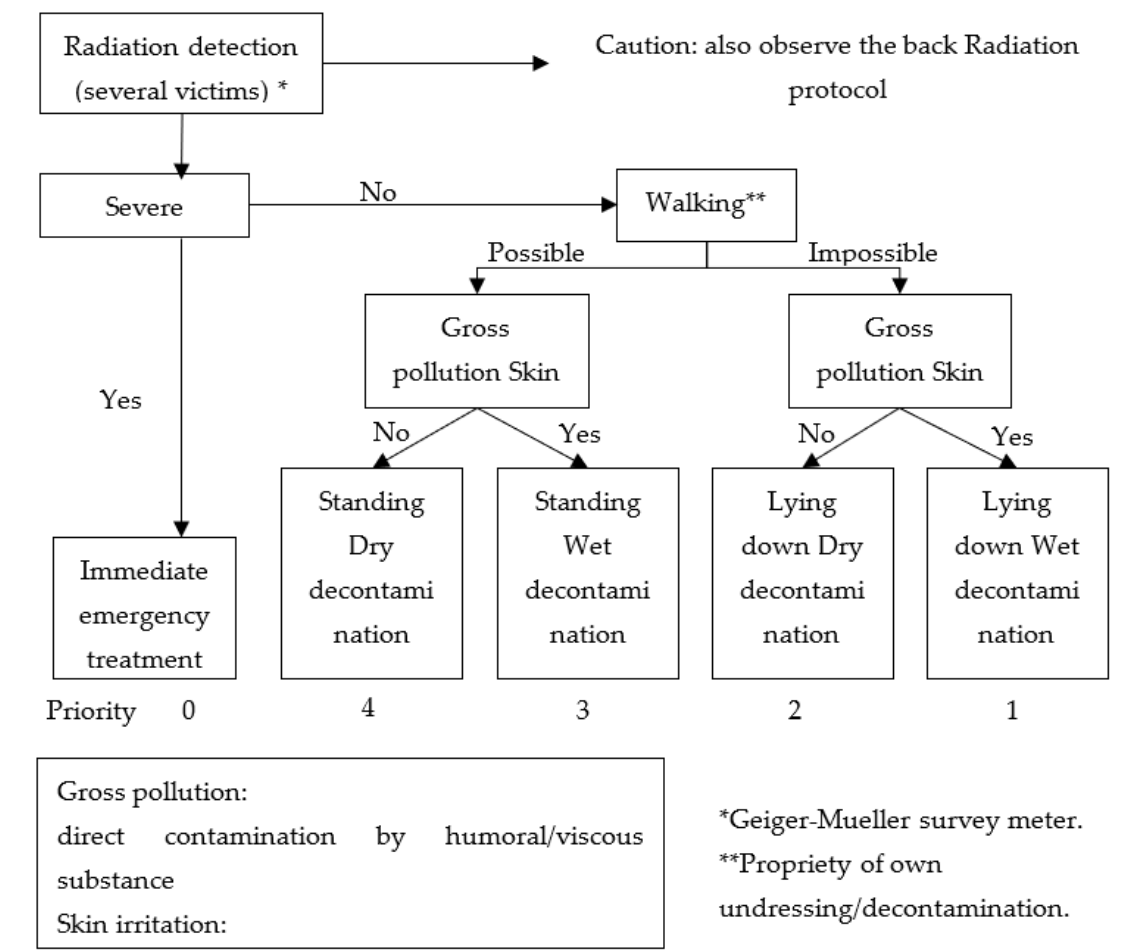
Figure 6. Flowchart for predecontamination triage.